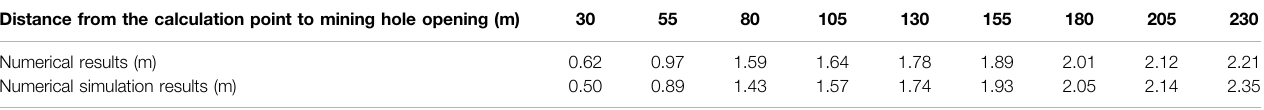
TABLE 14 | Inelastic zone width for the coal pillar calculated by numerical calculation and numerical simulation under the 0% fi lling rate condition of the West Bokaro open- pit mine. Distance from the calculation point to mining hole opening (m)